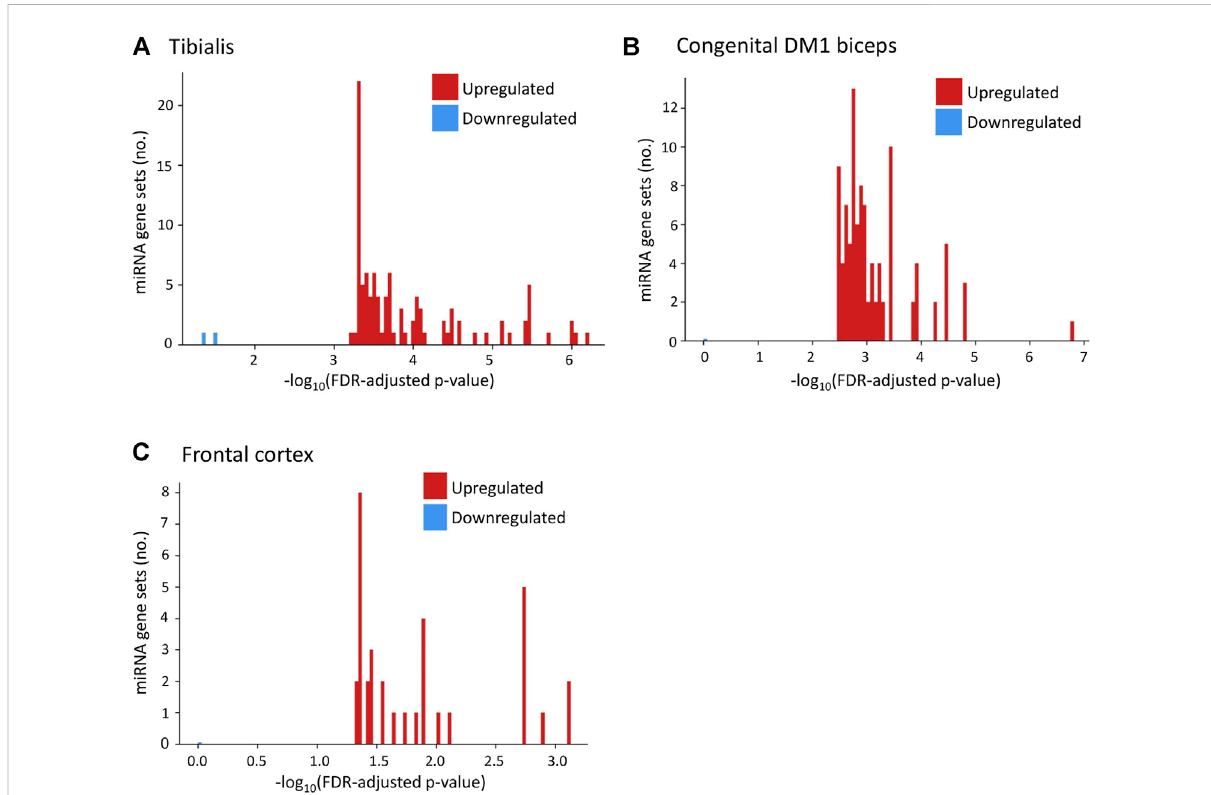
FIGURE 5 Upregulated genes in DM1 tissues are predicted targets of multiple miRNAs. Histograms present the number of miRNA gene sets enriched for upregulated (red) and downregulated (blue) genes in DM1 by their value of [ − log10( p -value)] for tibialis (A) , congenital DM1 biceps (B), and frontal cortex (C)